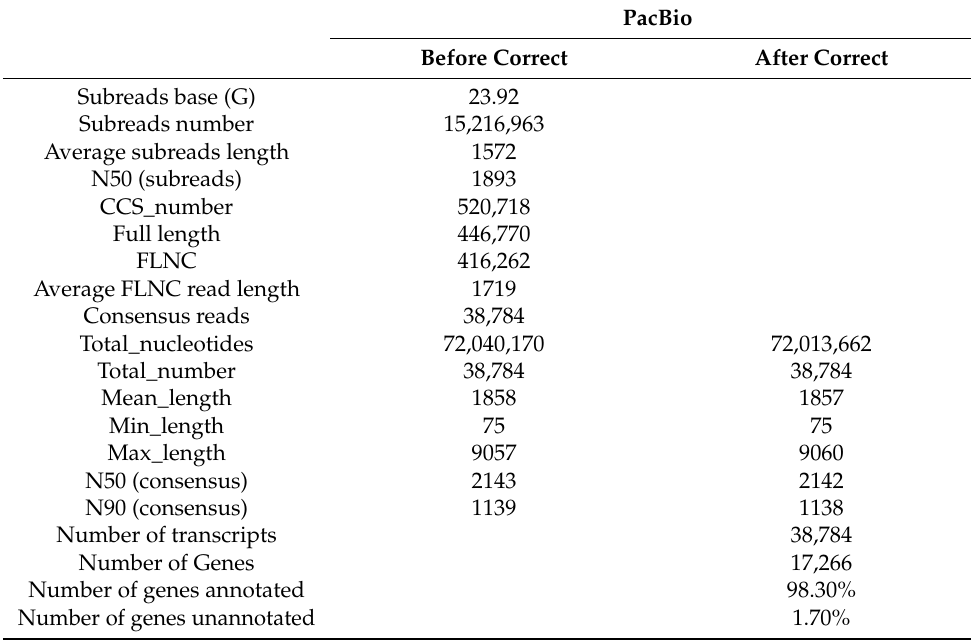
Table 1. Summary of PacBio transcripts of masson pine needles in the high and common resin yield. PacBio Before Correct After